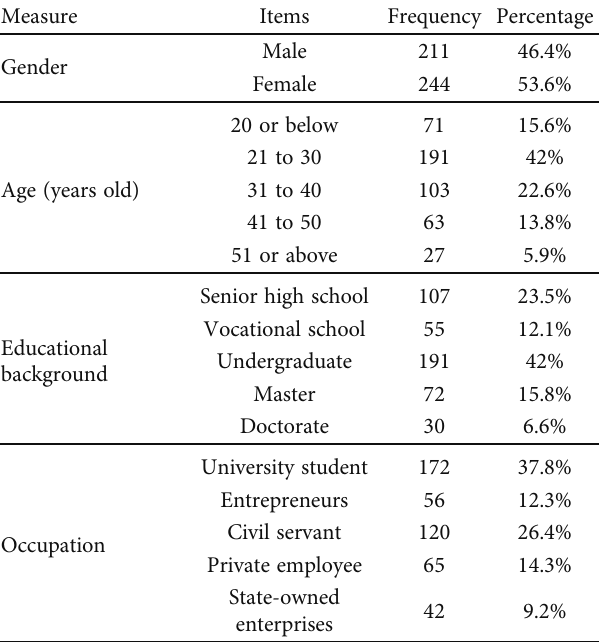
Table 2: Respondent